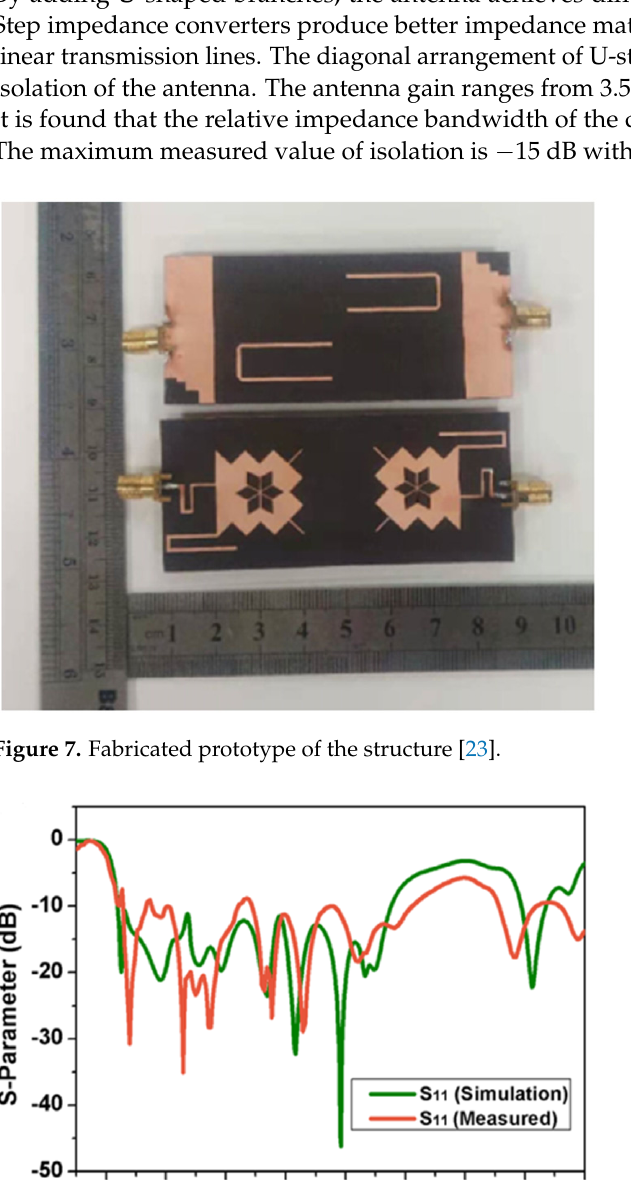
Figure 8. Simulated and measured S − parameters of the antenna [23].